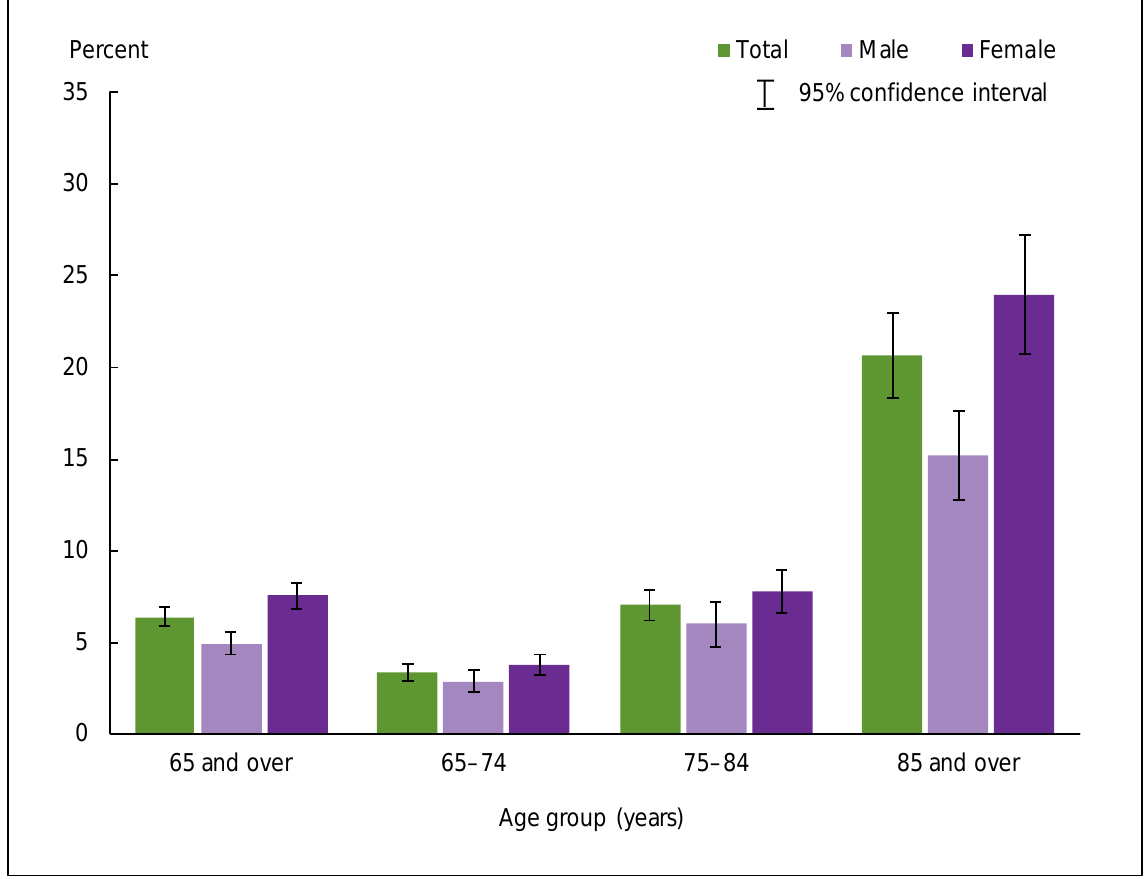
Figure 12.2. Percentage of adults aged 65 and over who needed help with personal care from other persons, by age group and sex: United States,